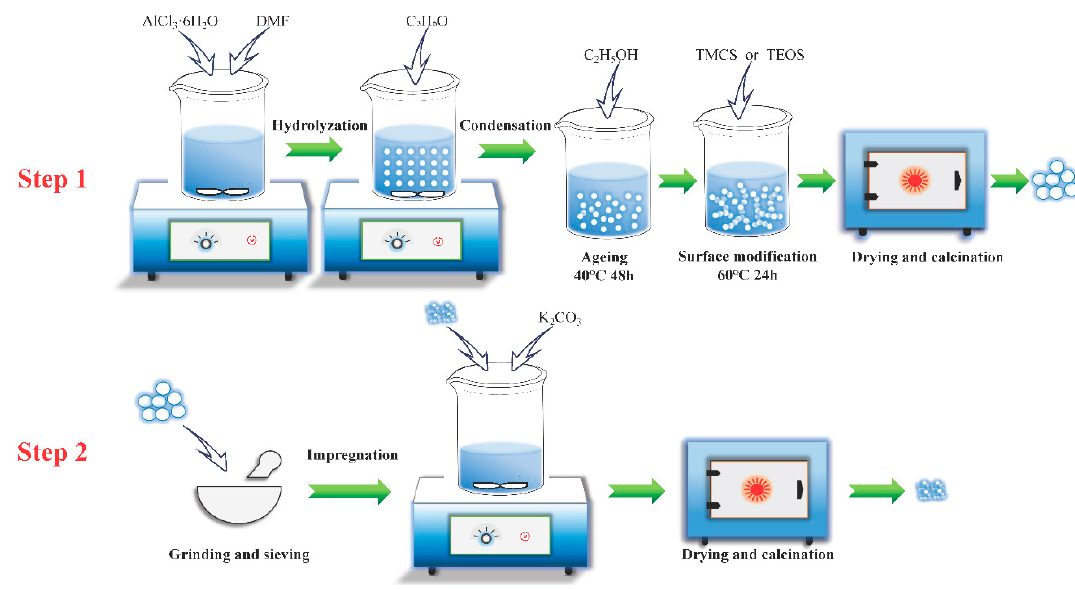
Figure 1. Schematic diagram of the preparation process of adsorbent.